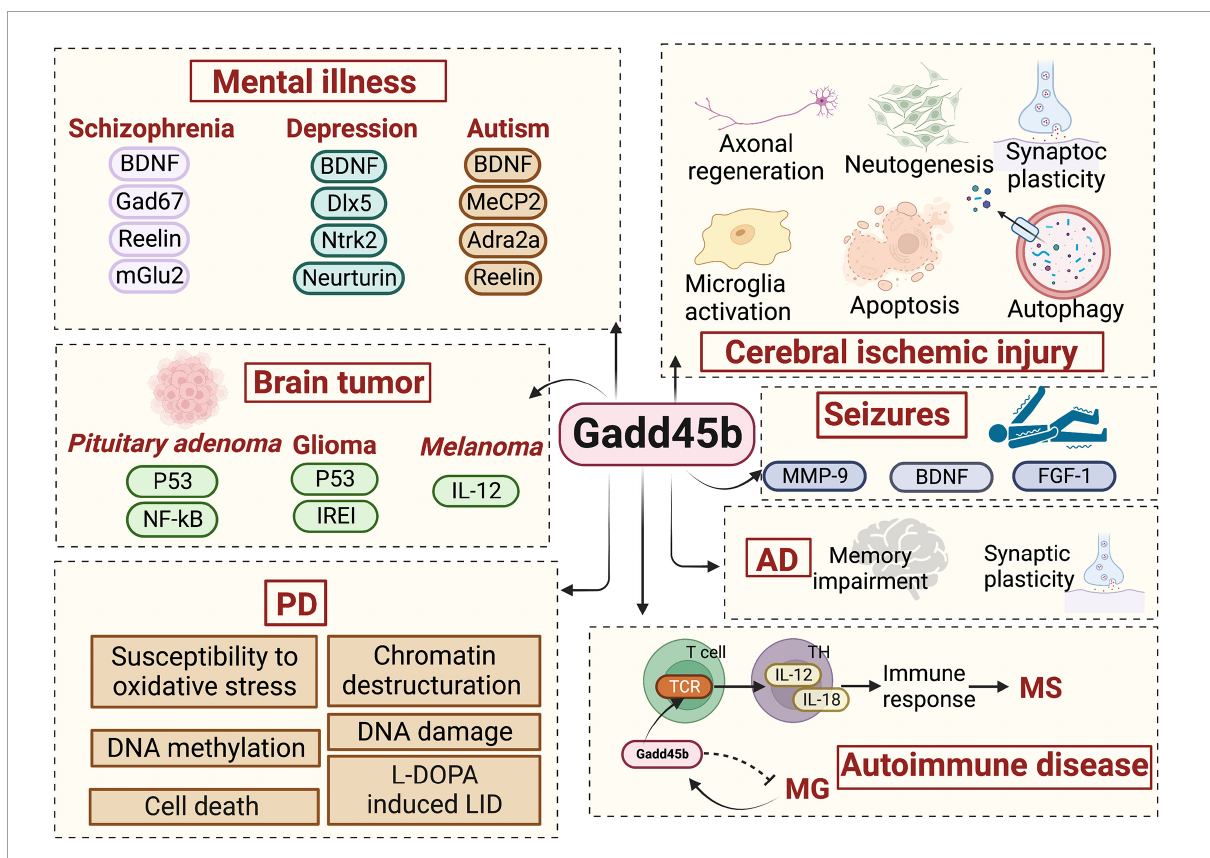
FIGURE1 The role of growth arrest and DNA damage-inducible beta (Gadd45b) in neurologic and neuropsychiatric